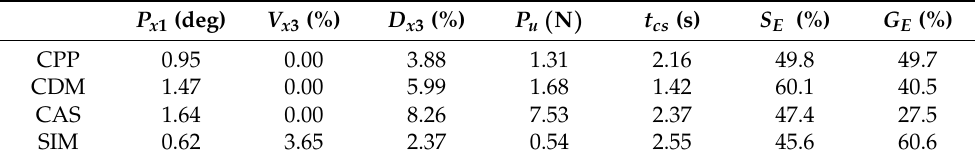
Figure 13. CIP input responses using CAS, CPP, CDM, and SIM methods. ( a ) Overall input re- sponses; ( b ) restricted input responses. Table 5. Controller performance comparison using nonlinear CIP model. 1 x P